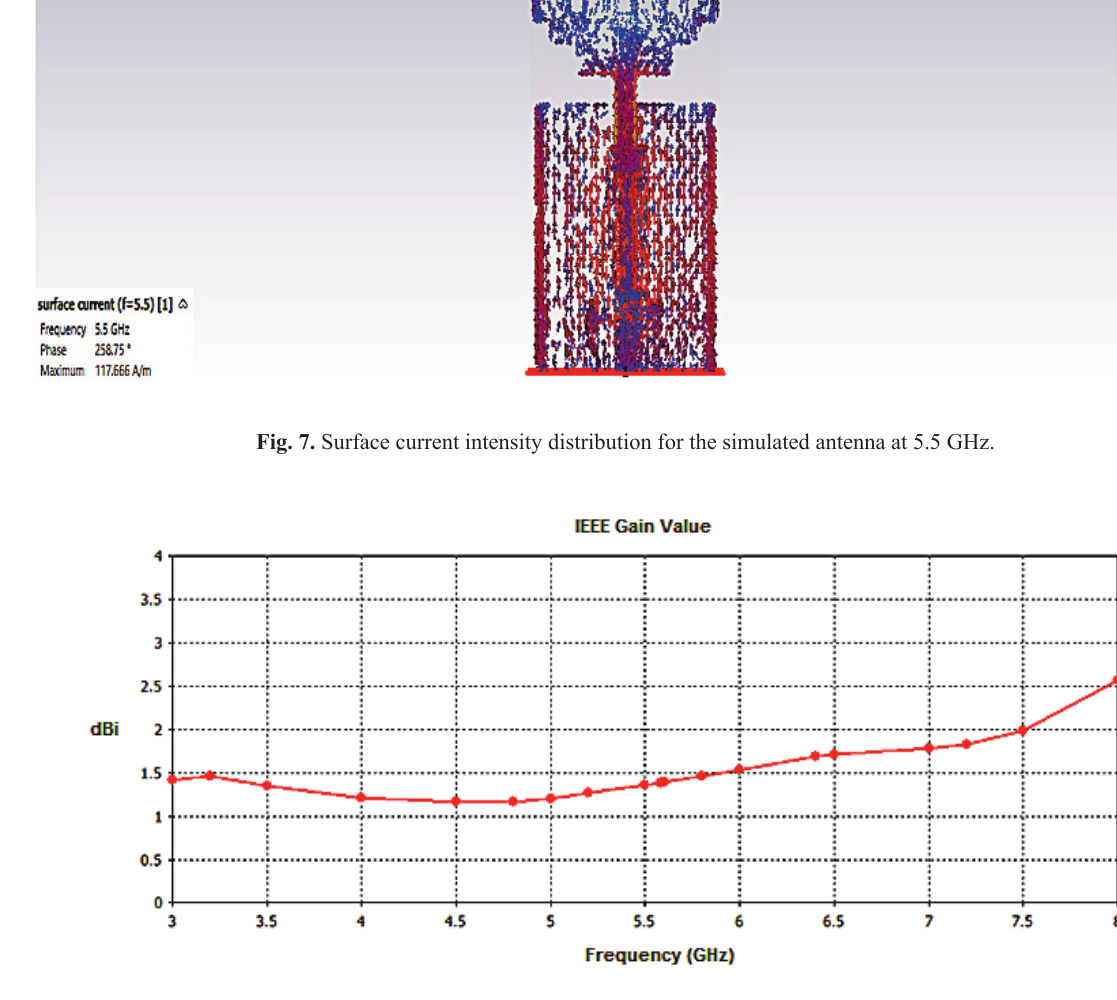
Fig. 8. Gain result for the projected